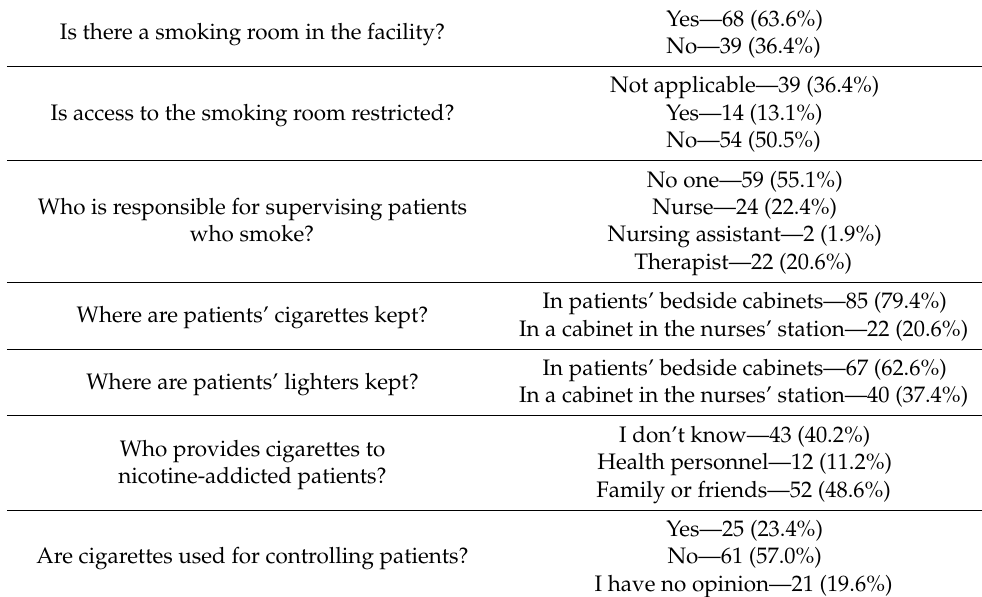
Table 2. Smoking policies and practices in psychiatric wards according to nursing personnel (n =